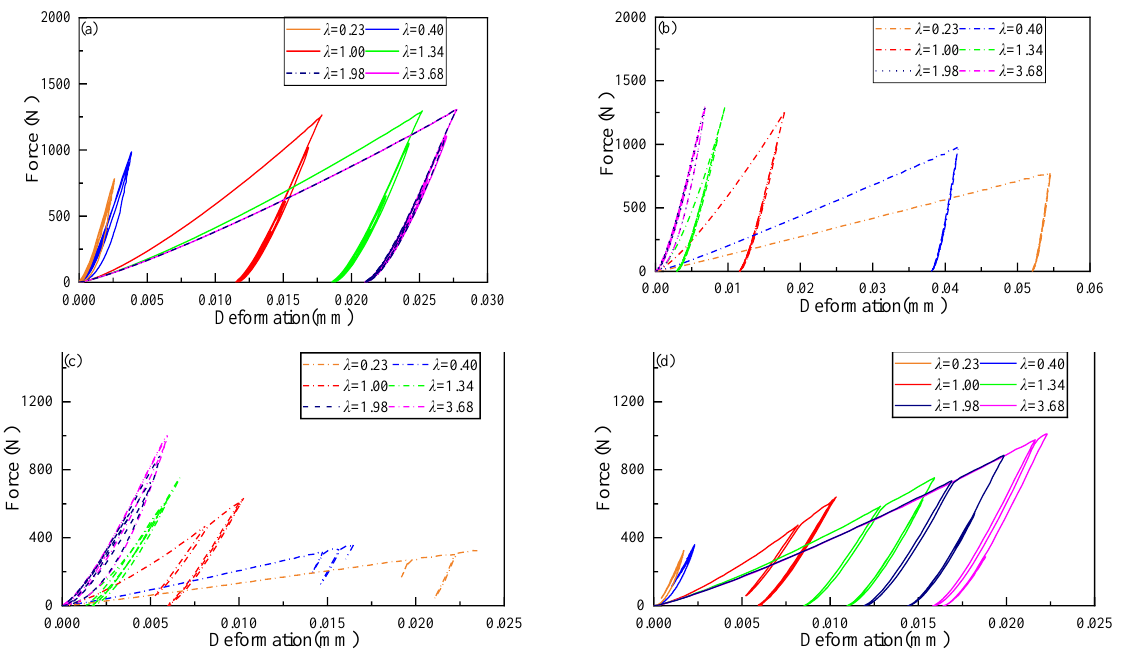
Figure 6. Contact force-deformation curves at different granule positions in six cases: ( a ) Contact force versus deformation of granule 5; ( b ) Contact force versus deformation of granule 6; ( c ) Contact force versus deformation of granule 10; ( d ) Contact force versus deformation of granule 11.